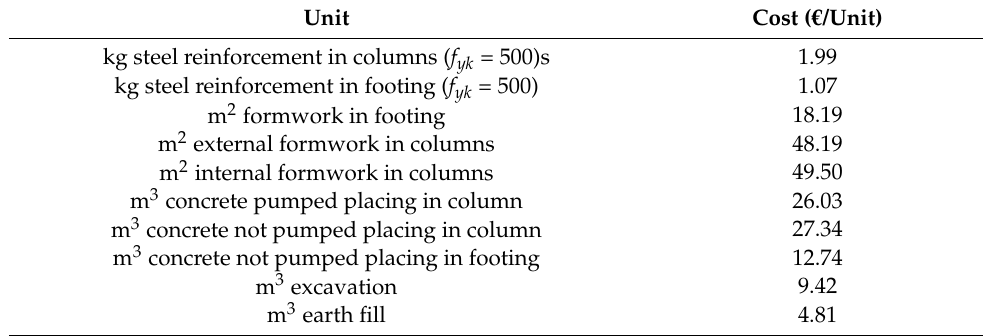
Table 2. Unit costs.